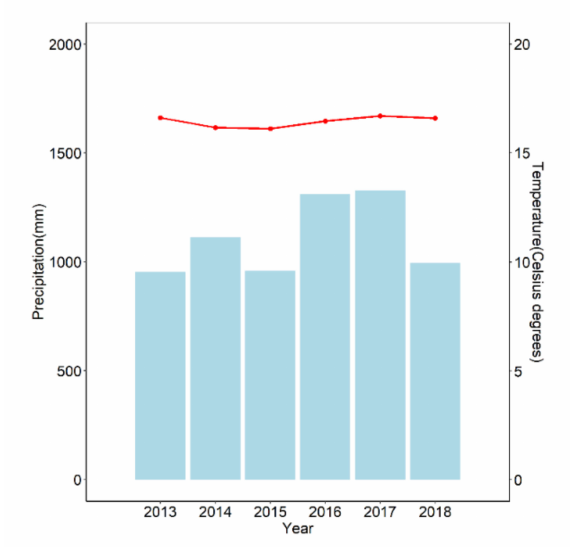
Figure 1. Annual mean temperature and total precipitation of the study site during the detected year